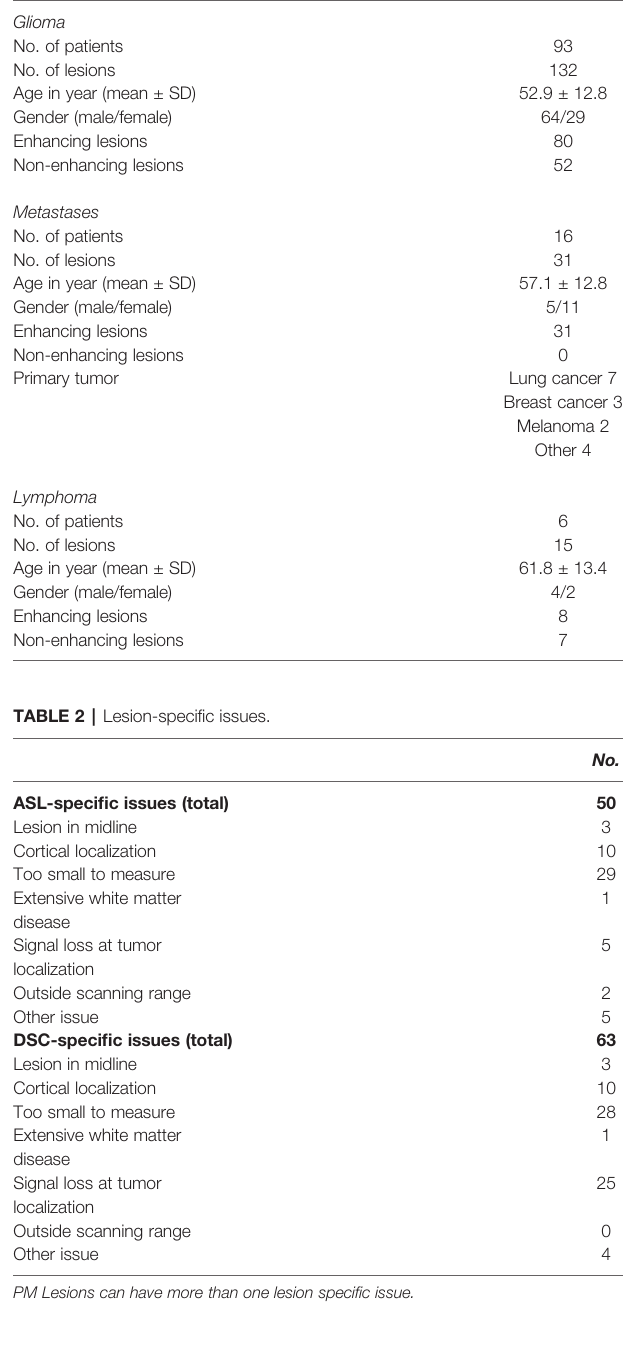
brain metastasis were within the same high range for both ASL- derived and DSC-derived leakage-corrected ratios (0.73 – 0.80) ( Table 4 and Figure 2 ). No AUCs were calculated for the lymphoma subgroups, given the insigni fi cant number of patients in these subgroups. The AUC for enhancing glioma was higher than for non-enhancing glioma (AUC = 0.78 – 0.80 versus AUC = 0.56 – 0.62, respectively), both for ASL-derived CBF (AUC = 0.78) and for DSC-derived rCBV ratios (AUC = 0.77 – 0.80). In brain metastasis, the AUC was lower for ASL-